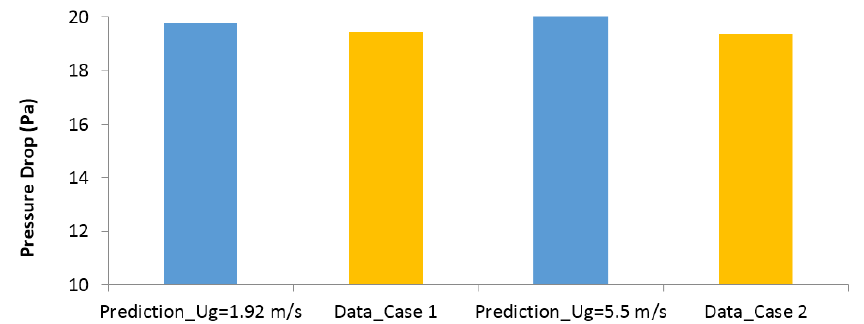
Figure 9. Predicted pressure drop vs. experimental data of Cases 1 and 2.